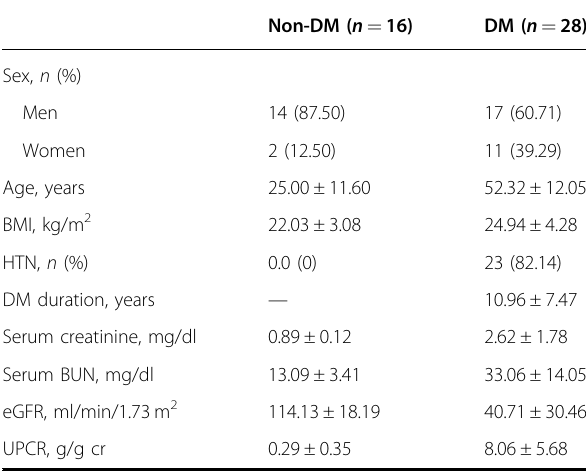
Table 1 Clinical parameters.